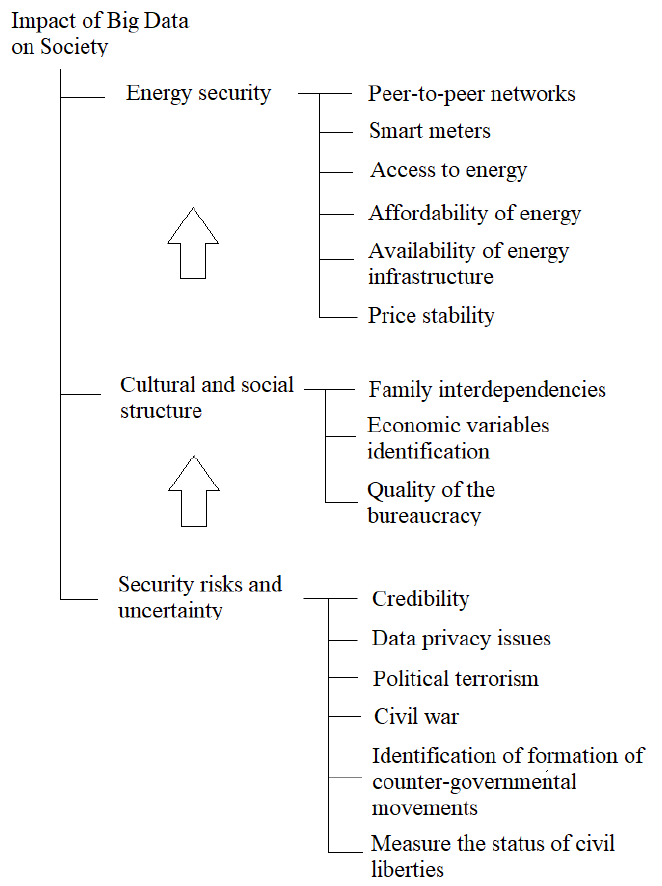
Figure 3. Flowchart diagram: Drivers of the Impact of Big Data on national economies and factors affecting society.